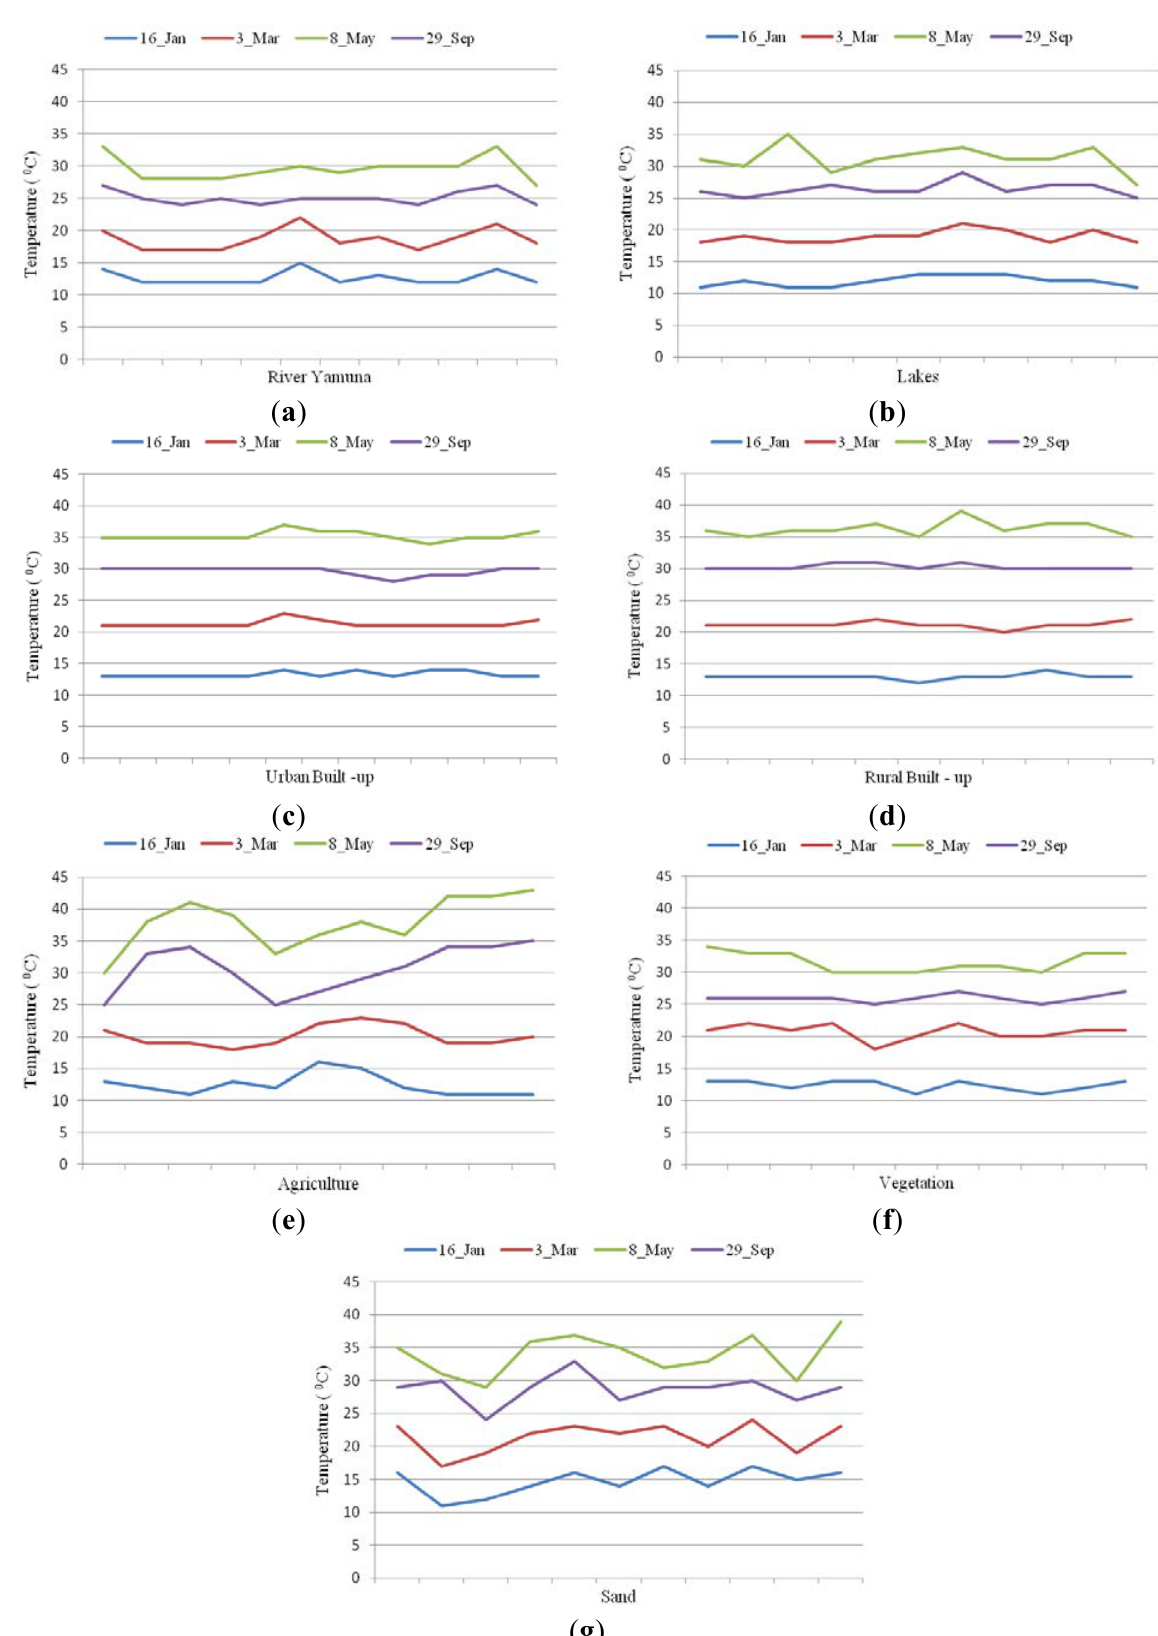
Figure 5. Inter-seasonal variation of surface temperature across land use/cover categories: ( a ) the Yamuna River; ( b ) lakes; ( c ) urban built-up; ( d ) rural built-up; ( e ) agriculture; ( f ) vegetation; and ( g )